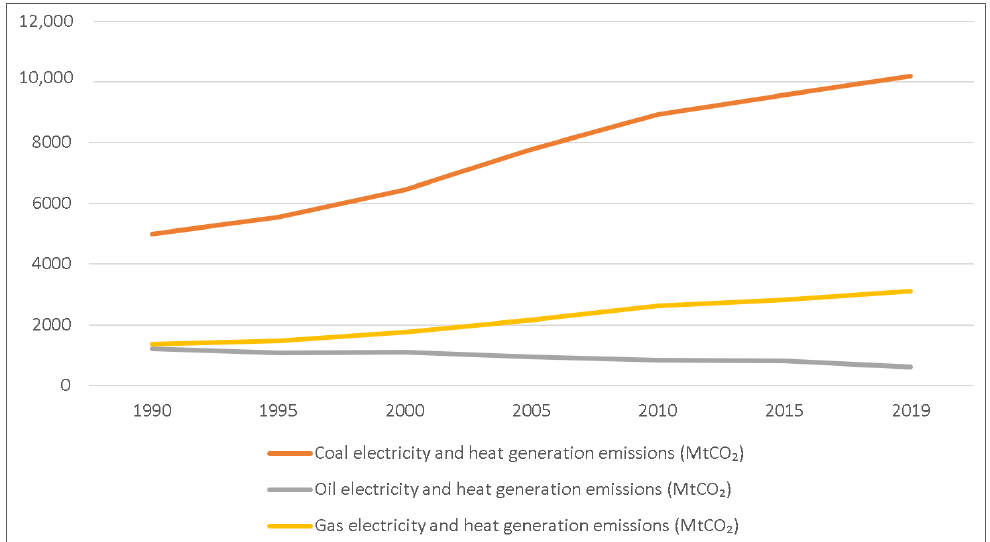
Figure 2. Global CO 2 emissions (MTCO 2 ) from electricity and heat by energy sources and year (1990–2019), derived from [19].